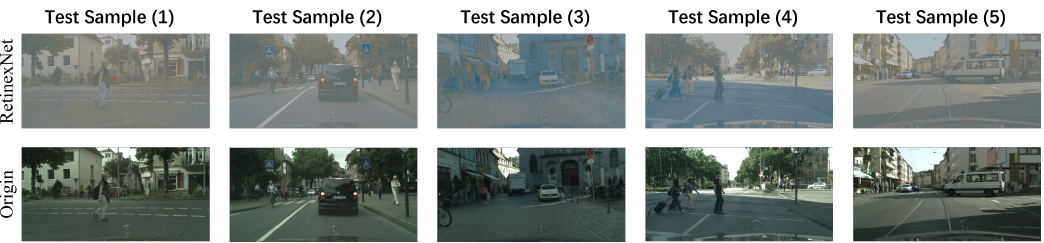
Figure 6. The results of five selected test samples passing through the RetinexNet